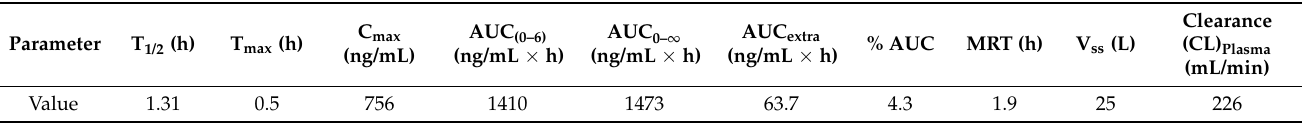
Figure 3. Plasma kinetics of SH045 in mice after intraperitoneal (i.p.) administration (20 mg/kg body weight). ( a ) Mean plasma concentration-time course of SH045, ( b ) semilogarithmic plot indicative for first-order elimination kinetics (Pearson’s r = −0.991). Table 6. Non-compartment analysis of pharmacokinetic parameters in plasma after single-dose administration of SH045 (20 mg/kg body weight, i.p.) in